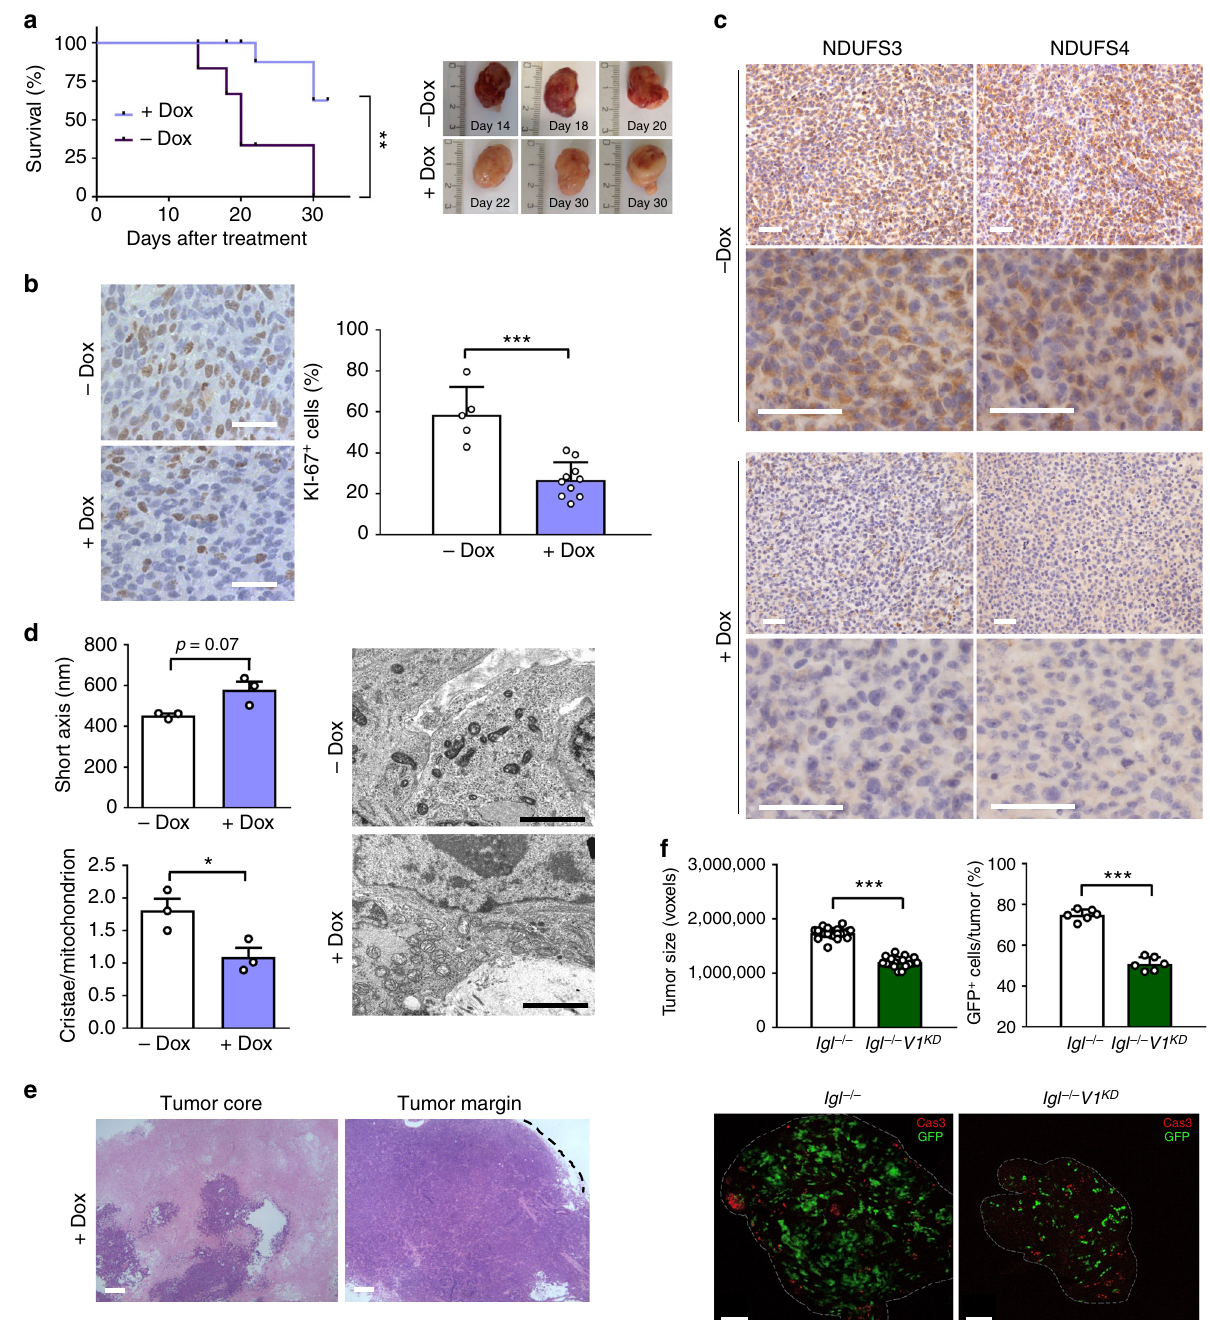
Fig. 2 Targeting CI arrests tumor progression and converts carcinomas into oncocytomas. a Kaplan – Meier survival curves of CD-1 nude mice injected with 143B − / − NDUFS3 cells and treated with ( n = 7) or without ( n = 5) Dox (1 mg mL − 1 in drinking water). Survival end-point: xenografts reaching 10% of animal weight. Representative xenografts are shown. b Quanti fi cation of cells displaying KI-67 positive nuclei in 143B − / − NDUFS3 tumors treated with ( n = 7) or without ( n = 5) Dox (1 mg mL − 1 in drinking water) (df = 13, t = 5.539). Representative image of KI-67 immunohistochemistry staining is shown. Scale bars: 50 µ m. Data are mean + s.e.m. c Immunohistochemistry staining of CI subunits in xenografts treated with or without Dox (1 mg mL − 1 in drinking water). Representative images are shown. Scale bars: 50 µ m. d Short mitochondrial axis width ( n = 3, df = 4, t = 2.4) and cristae number ( n = 3, df = 4, t = 3.1) evaluation, with representative electron micrographs of xenografts treated with or without Dox (1 mg mL − 1 in drinking water). Scale bars: 2 µ m. Data are mean + s.e.m. e Hematoxylin/eosin staining of 143B − / − NDUFS3 tumors treated with Dox. Tumor margin is indicated by the dashed line. Representative images are shown. Scale bars: 100 µ m. f Immuno fl uorescence for caspase 3 (Cas3) of CI-competent ( lgl − / − ) and de fi cient ( lgl − / − V1 KD ) epithelial tumors (GFP + ) of the fl y. Dashed lines delineate tumor margin. Scale bars: 80 µ m. Tumor size ( n = 25, df = 48, t = 13.2) and the average number of GFP + cells ( n = 6, df = 10, t = 13.8) were evaluated. Data are mean + s.e.m. In each panel, statistical signi fi cance is speci fi ed with asterisks (* p < 0.05, ** p < 0.01, *** p <